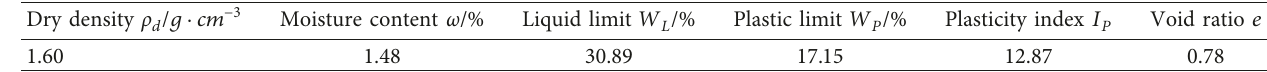
Figure 6: The change of the shear index with the content of the microbial cement solution. (a) The change of cohesion with the content of the microbial cement solution. (b) The change of the internal friction angle with the content of the microbial cement solution. Table 2: Physical index of undisturbed loess.